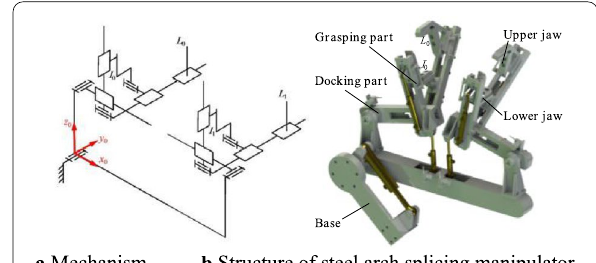
Figure 9 Schematic diagram of steel arch splicing manipulator